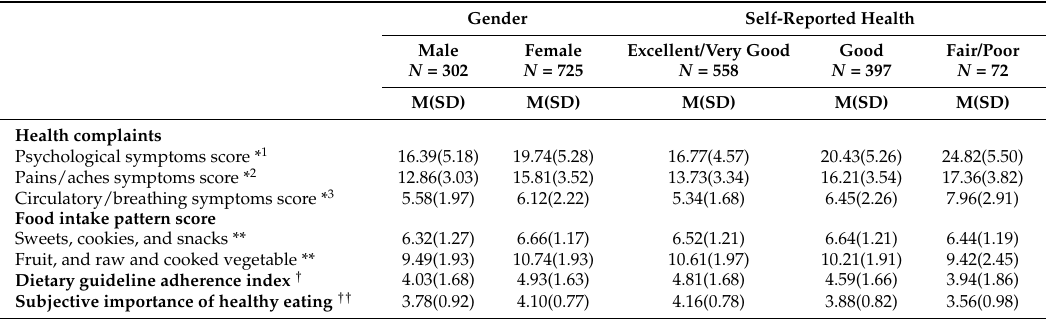
Table 3. Health complaints and eating habits of undergraduates by gender and self-reported health, University of Turku, Finland, 2013–2014.